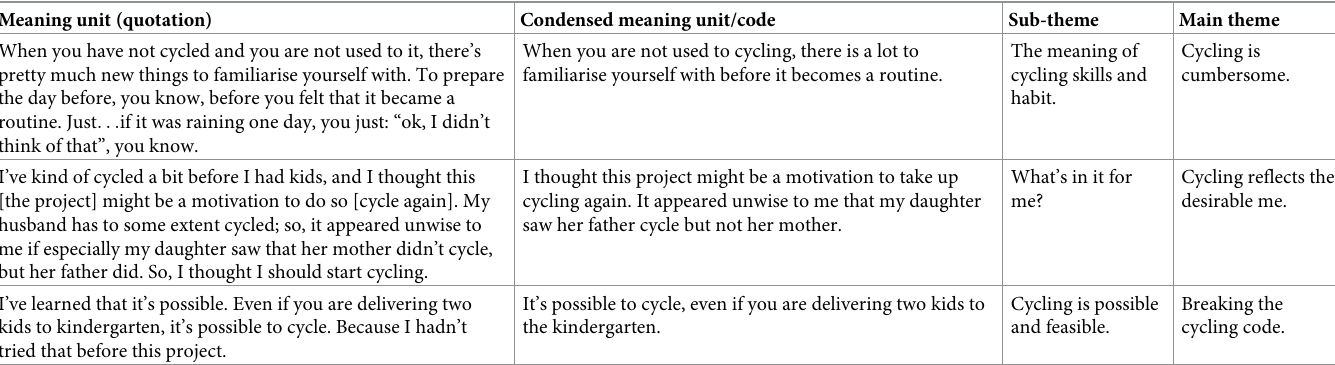
Table 3. Illustration of the relation between meaning units, condensed meaning units, subthemes, and main themes from systematic text condensation. Meaning unit